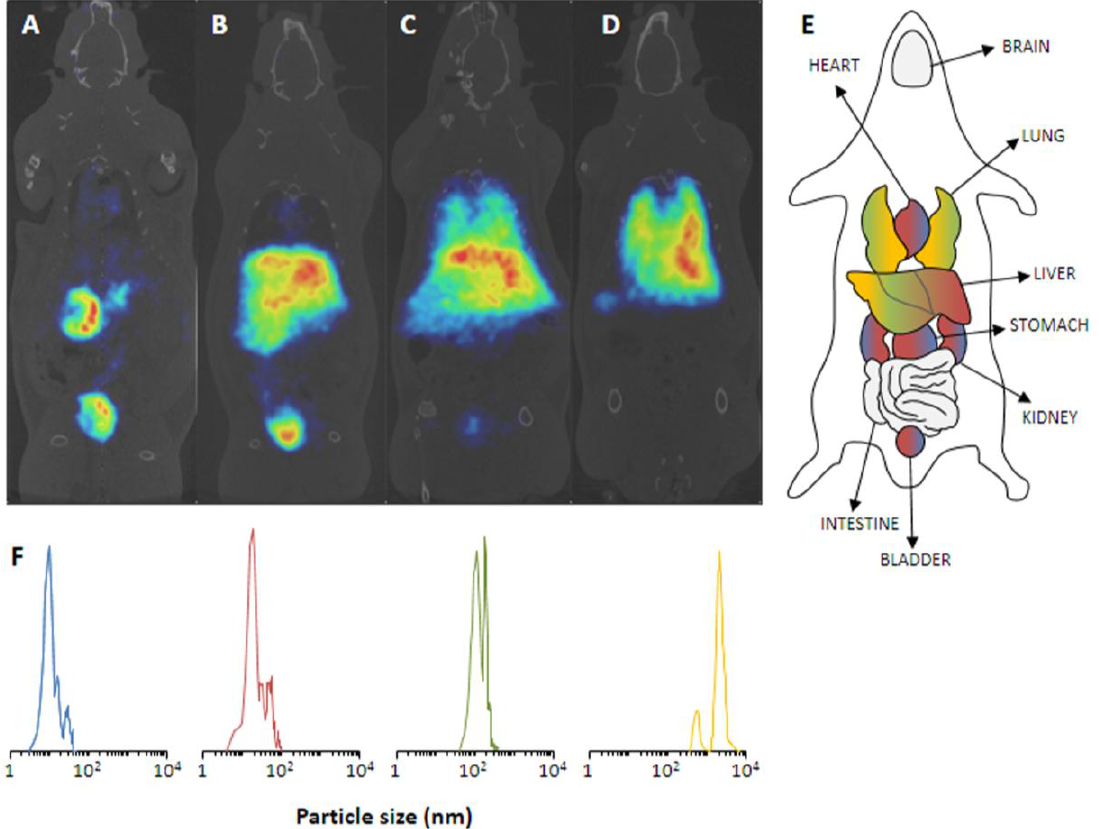
Figure 6. ( A – D ) PET images of 13 N-nanoparticles of different size in Sprague-Dawley rats (60 min p.i.). ( A ) 10 nm, ( B ) 40 nm, ( C ) 150 nm, ( D ) 10 µm. ( E ) Schematic